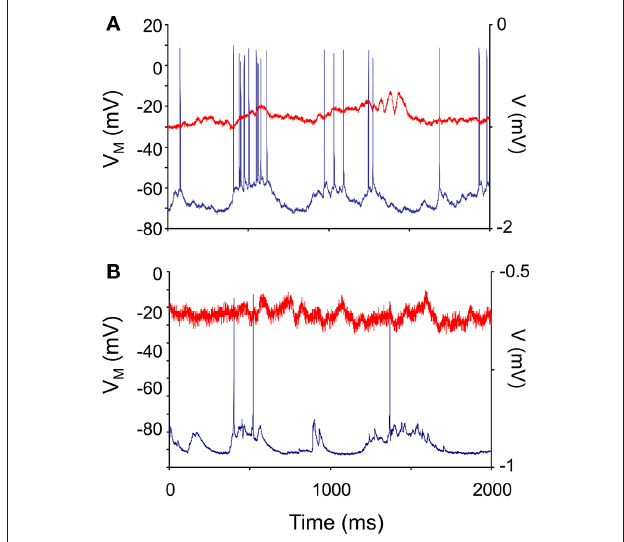
FiguRe 1 | Neocortical neurons in control and R6/2 model mice show spontaneous membrane potential fluctuations. In vivo intracellular recordings (blue traces) were taken from 10-week-old non-transgenic littermate control (A) and R6/2 (B) agranular neocortical neurons. All recorded neurons showed subthreshold fluctuations. The red traces are the electrocorticogram (ECoG)